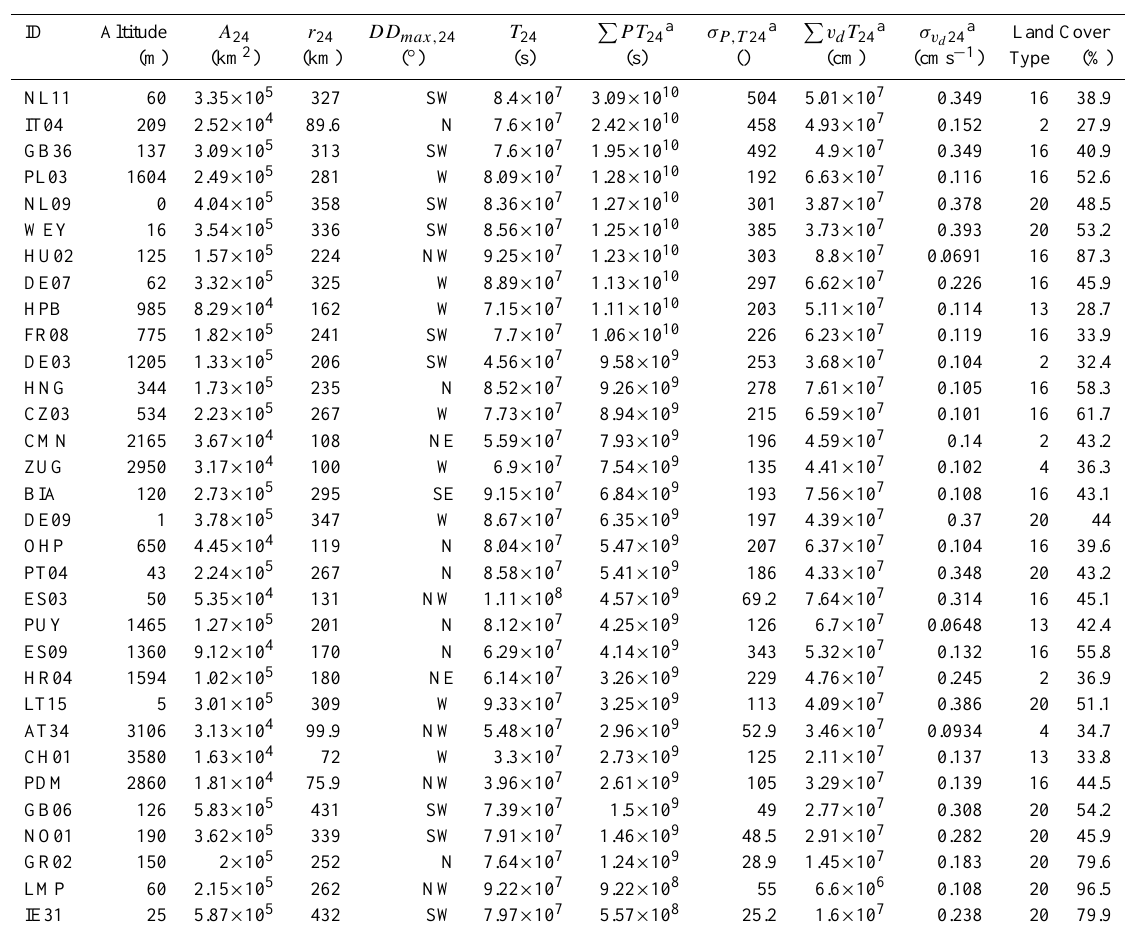
Table 2b. Same as Table 2a but for 24h catchment